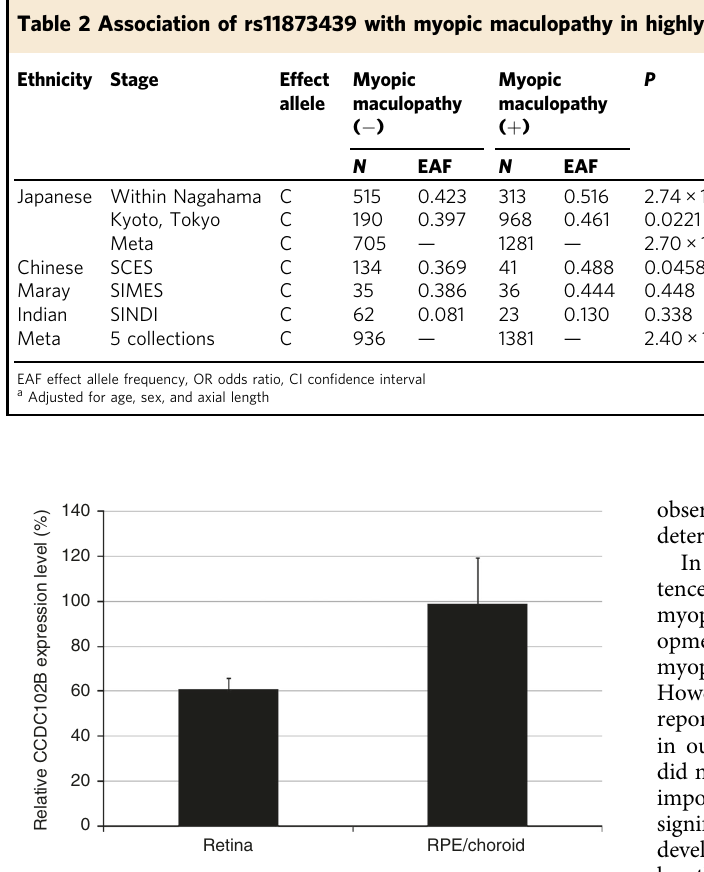
Fig. 2 Expression of CCDC102B in the human retina and RPE-choroid. CCDC102B expression in the human retina and human RPE-choroid normalized to glyceraldehyde-3-phosphate dehydrogenase for cDNA quanti fi cation. Human retinal cDNA and RPE-choroid cDNA were obtained from one individual, respectively, and the average of duplicate experiments were used for qPCR analysis. RPE: retinal pigment epithelium. Error bars show standard